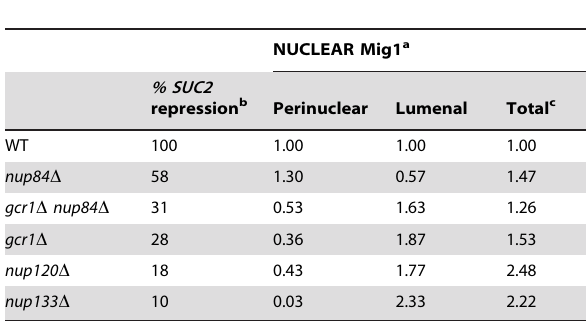
Table 2. Repression of SUC2 correlates with subnuclear targeting of